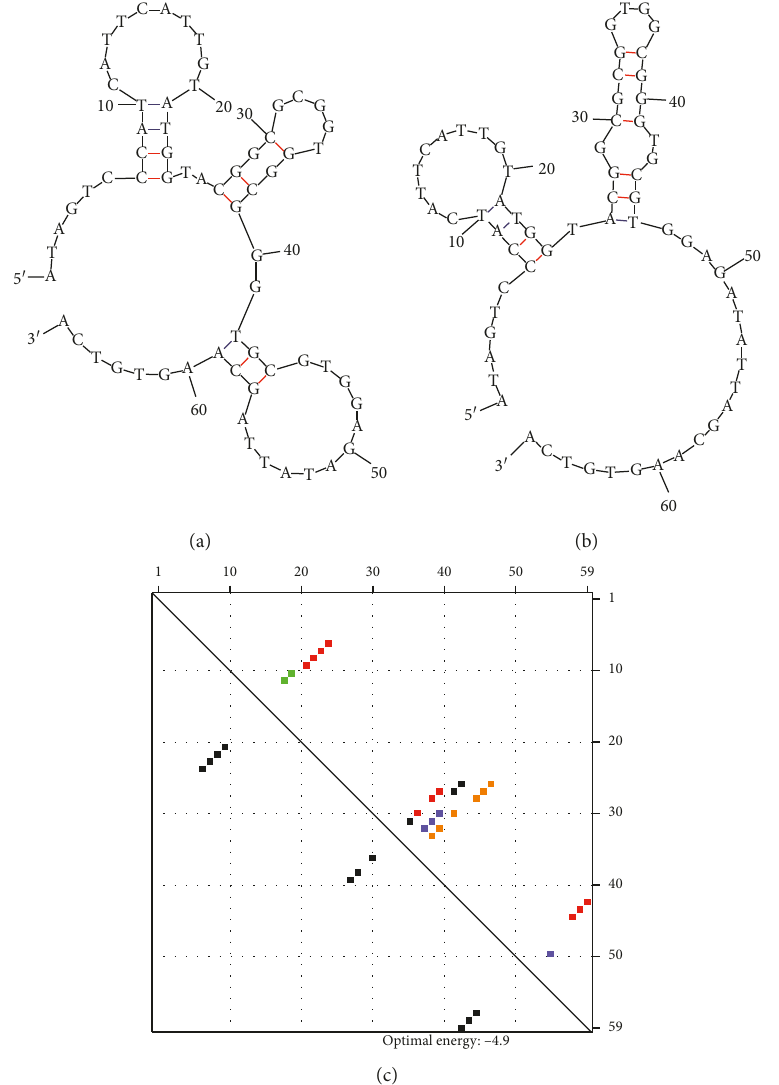
Figure 3: Possible secondary structures of the alpha-synuclein aptamer. (a) Structure 1. (b) Structure 2. Both structures show 4 loop and 3 stem regions. (c) Comparison and energy levels (dG) of both